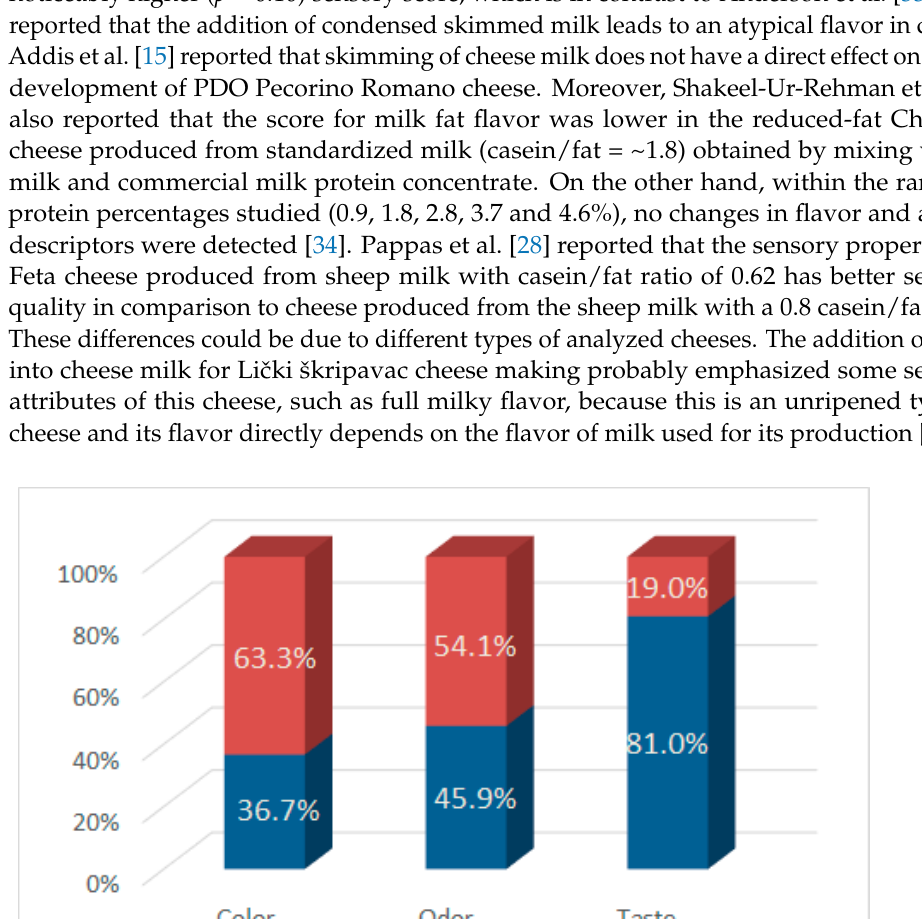
Figure 2. Consumer’s average sensory score of evaluated cheeses ( p = 0.10) using a scale of 1 to 5 (1 = unacceptable and 5 = very acceptable). 1—without milk standardization; 2—standardization casein/fat = 0.7 by addition of skimmed milk powder; 3—standardization casein/fat = 0.7 by skim- ming part of the milk fat. 4. Conclusions This study demonstrated the feasibility of standardizing casein/fat ratio of cheese milk by the addition of skimmed milk powder or by skimming part of the milk fat. By both types of standardization, milk fat content in Li č ki škripavac cheese decreased, while the content of protein increased, which resulted in higher actual and adjusted yield, as well as higher consumer’s sensory score. The addition of skimmed milk powder in the production of soft unripened cheeses such as Li č ki škripavac cheese probably contributes to its full milky flavor and better squeaking property. These attributes are the most im- portant sensory attributes of Li č ki škripavac cheese. However, further research of textural properties of Li č ki škripavac cheese produced from reformulated milk are needed. Author Contributions: Conceptualization and methodology, S.K.; investigation, I.D.Š., M.T.K. and J.A.; formal analysis, I.D.Š., M.T.K. and A.R.; data curation, K.S. and A.R.; writing—original draft